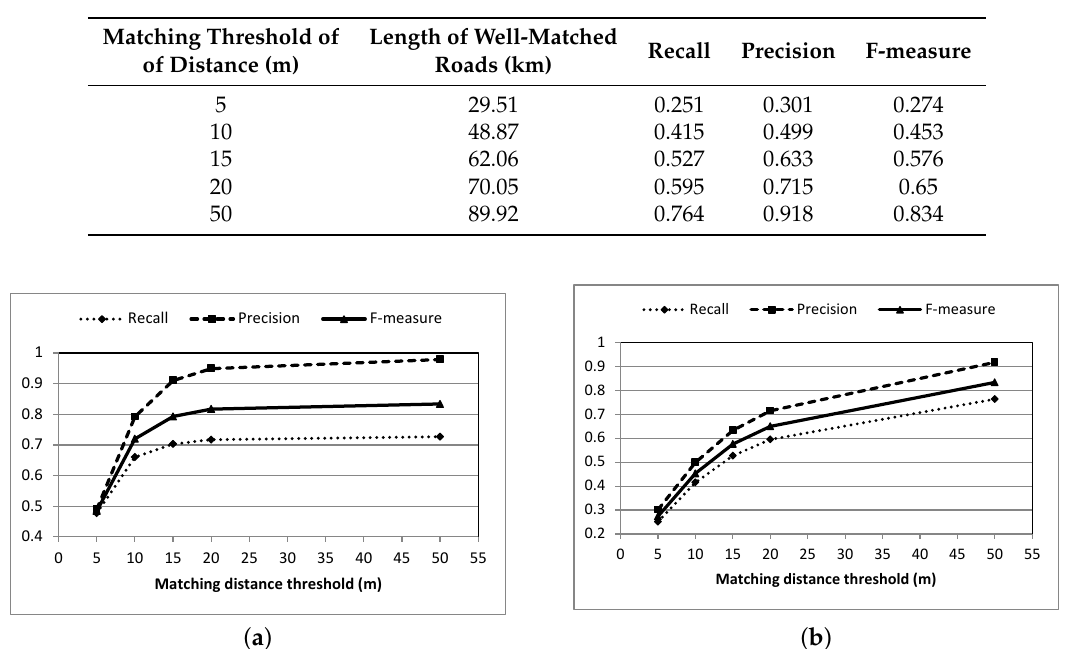
Table 4. Matching results of Davies’ method for the Wuhan dataset.